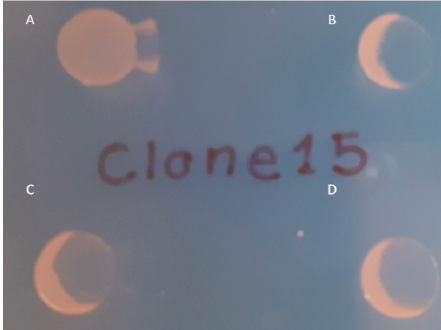
Figure 2. Spot test results confirming the restoration of susceptibility to ϕ BO1E infection observed in BO-FR-1(pACYC-wbaP). Strains are as follows: BO-FR-1 ( A ), KKBO-1 ( B ), BO-FR-1(pACYC-wbaP) ( C ) and ( D ). Ten μ L of cells in suspension of each strain were spotted on a LBA plate and partially layered with 5 μ L of ϕ BO1E (7 × 10 7 PFU/mL).